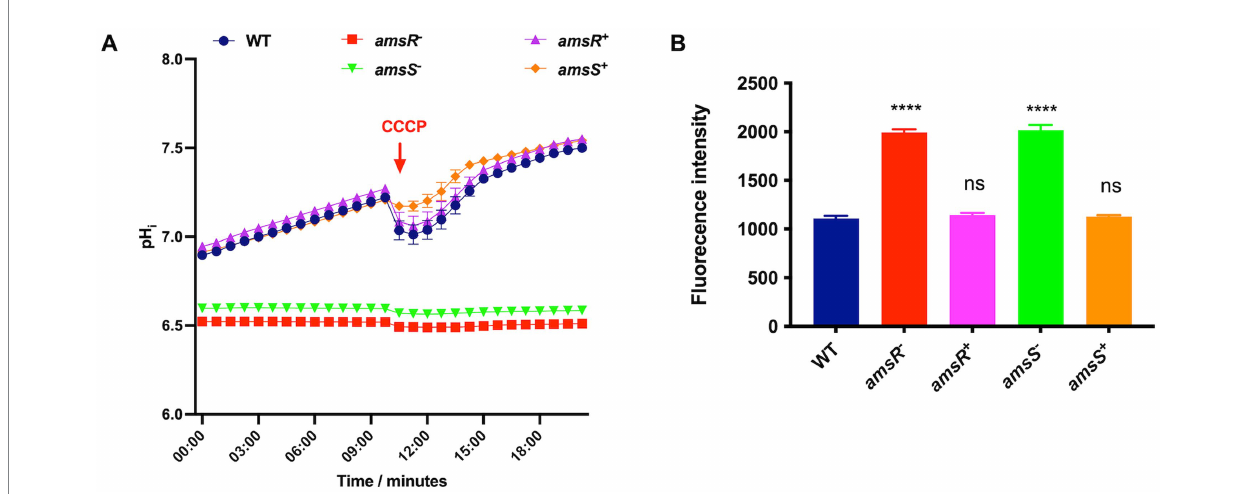
FIGURE 3 Acinetobacter baumannii amsSR mutants have a reduced intracellular pH and depolarized membranes. (A) Intracellular pH was measured using the dye BCECF_AM. Exponentially growing cells were treated with the dye alongside the addition of glucose to a final concentration of 10 mM. A red arrow indicates the time at which CCCP was added to all strains. (B) Depolarization of cytoplasmic membranes measured by release of the DiSC3 (5) dye. One-way analysis of variance, with Dunnett’s multiple-comparisons test, was used to assess statistical significance in comparison to wild-type, **** p < 0.0001. ns, not significant. All data is derived from three independent biological replicates. Error bars ±